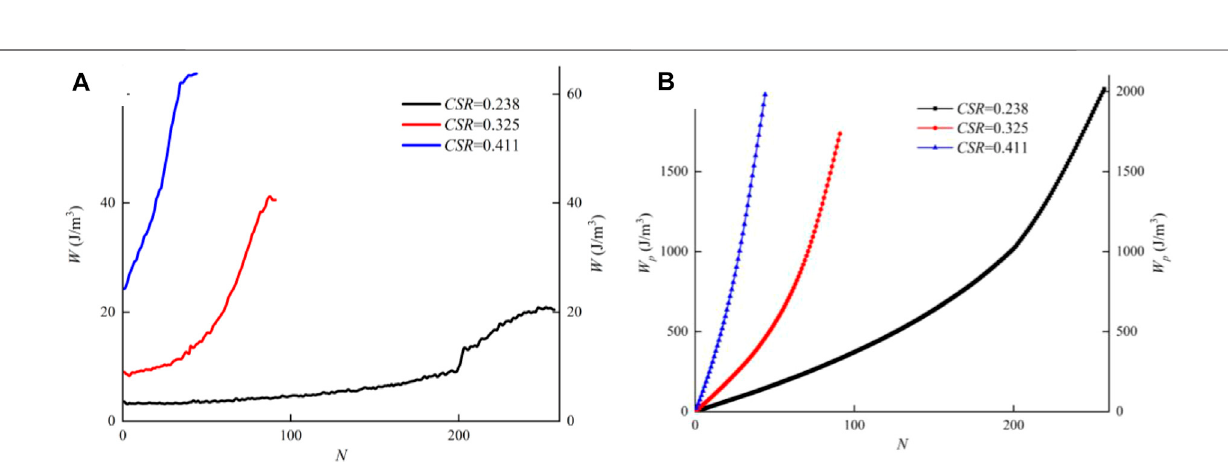
FIGURE 9 | Evolution characteristics of dissipated energy under different cyclic shear stress ratios: (A) dissipated energy per cycle and (B) cumulative dissipated energy.